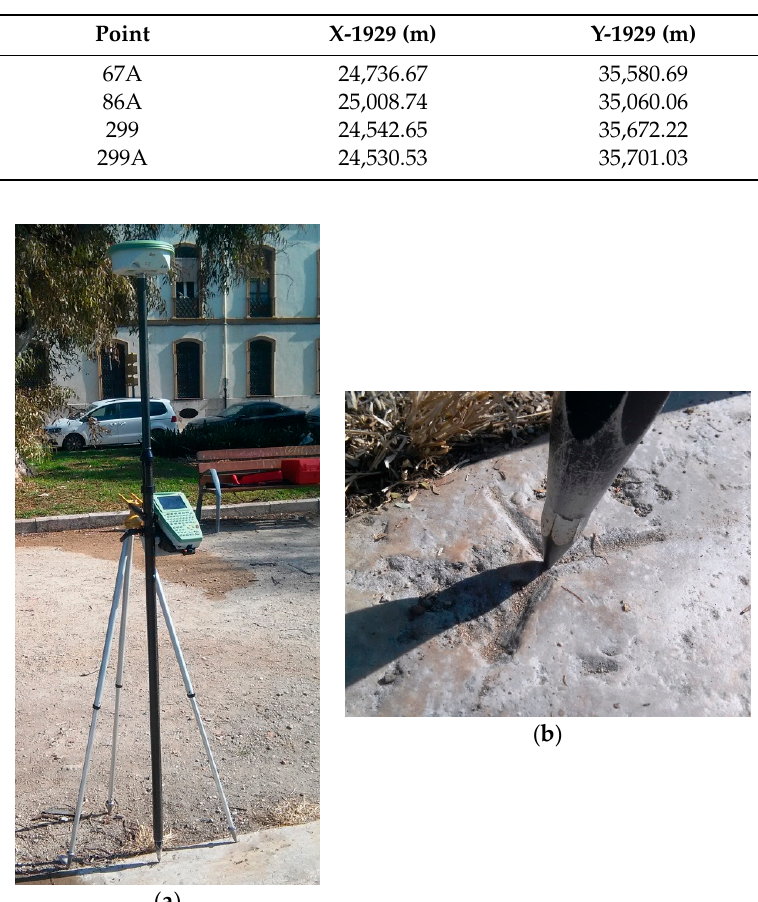
Table 7. Vertices from the field books used to check the mathematical model.